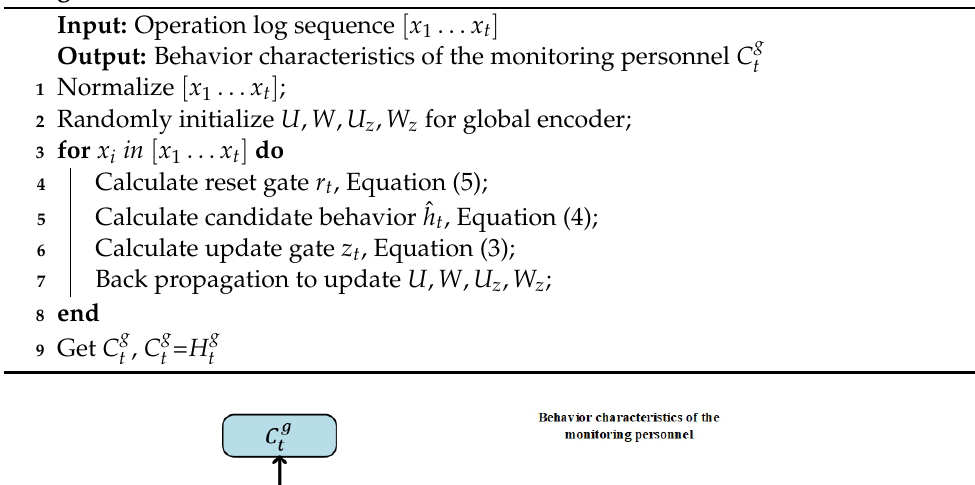
Algorithm 1: Global encoder.